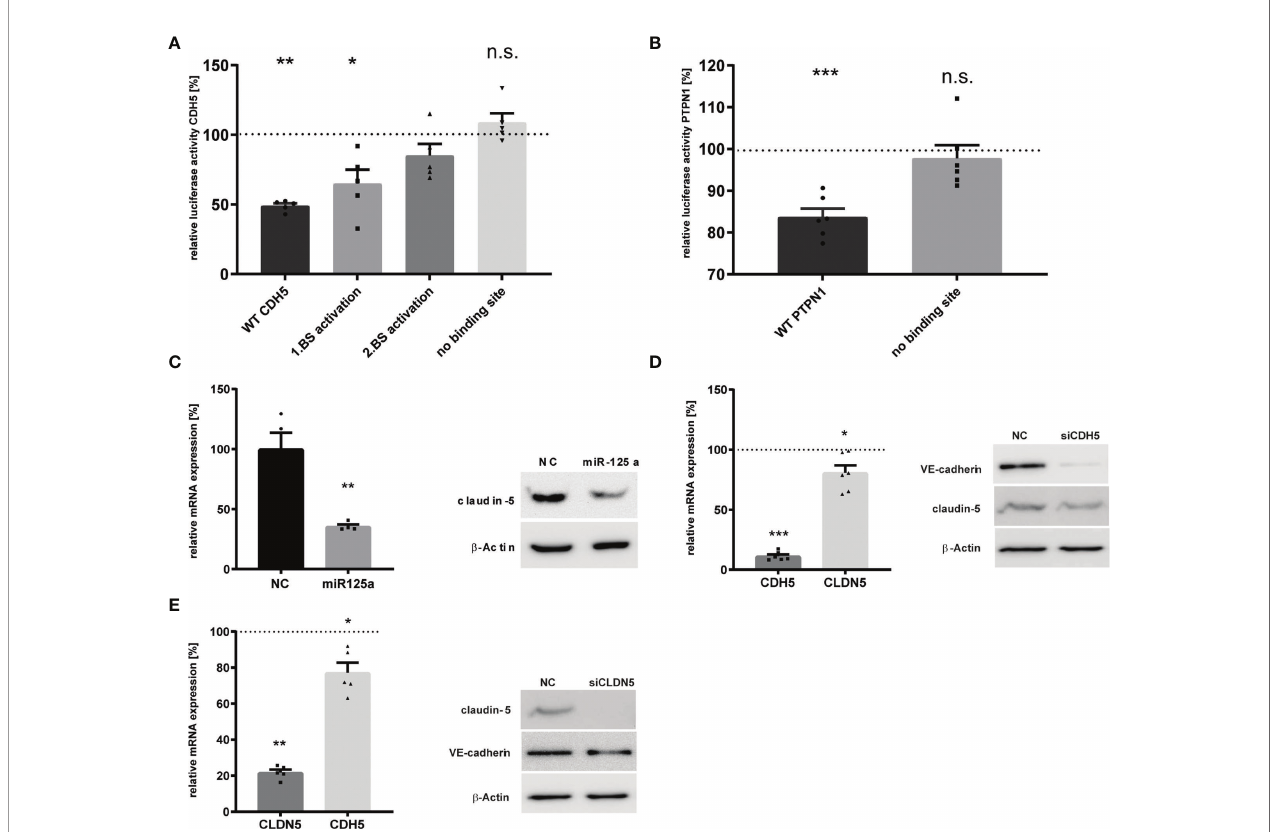
FIGURE 2 | Validation of the miR-125a-related network in HUVEC. (A) CDH5 3`UTR Luciferase reporter gene activity after co-transfection of the luciferase constructs with miR-125a or scrambled control (NC). Luciferase constructs: wt_CDH5: both binding sites of miR-125a in the CDH5 3`UTR are functional; mut1_miR- 125a: site-directed mutagenesis of binding site 1; mut2_miR-125a: site-directed mutagenesis of binding site 2; mut1+2_miR-125a: site-directed mutagenesis of both binding sites (n=5, p<0.01). (B) PTPN1 3`UTR Luciferase reporter gene activity with functional miR-125a binding site (wt PTPN1) and site-directed mutagenesis of the miR-125a binding site (mut1_miR-125a). n=6 p<0.001). (C) mRNA (left) and protein (right) expression of Claudin-5 after transfection with miR-125a or scrambled control (NC). n=4, p<0.01. (D, E) Knock-down of CDH5 (D) and CLDN5 (E) by RNA interference. mRNA (left) and protein (right) levels as measured by qRT-PCR and SDS-PAGE, respectively. n=5-6. ***p<0.001, **p<0.01, *p<0.05, n.s., not signi fi